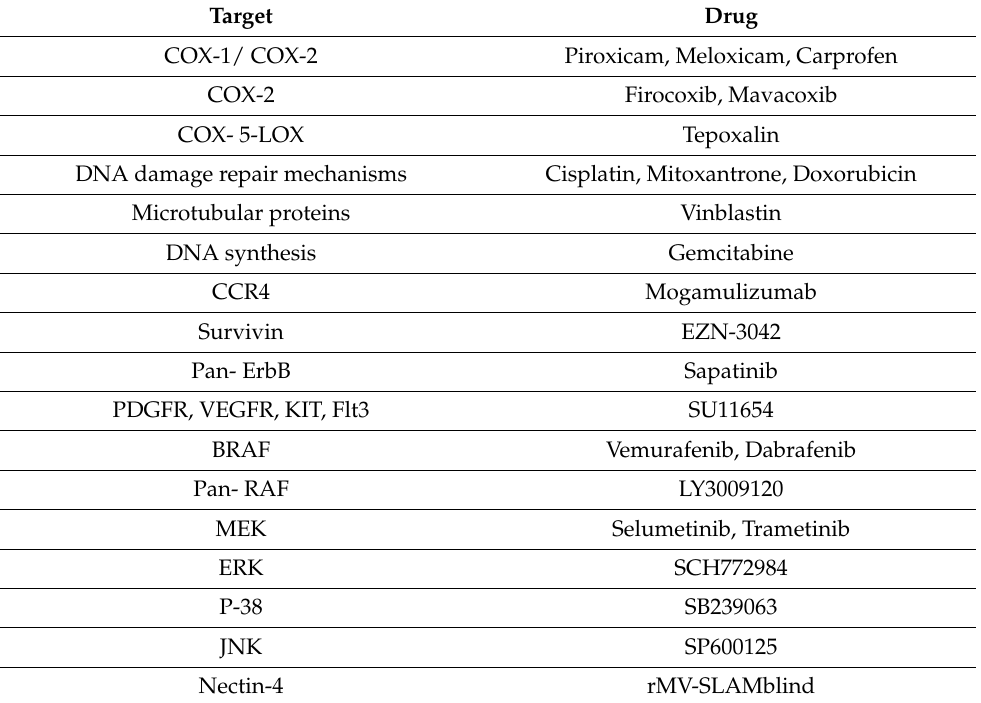
Table 1. Established and proposed therapeutic targets in canine